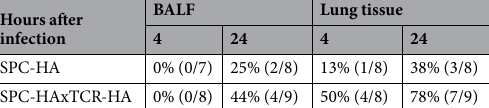
Table 2. Clearance of S . pneumoniae from the respiratory tract. SPC-HA and SPC-HAxTCR-HA mice were oropharyngeally inoculated with 1.5 × 10 4 CFU S . pneumoniae . Depicted are percentages of pneumococci-free samples (cleared sample/total samples). Values correspond with data given in Fig. 6a and